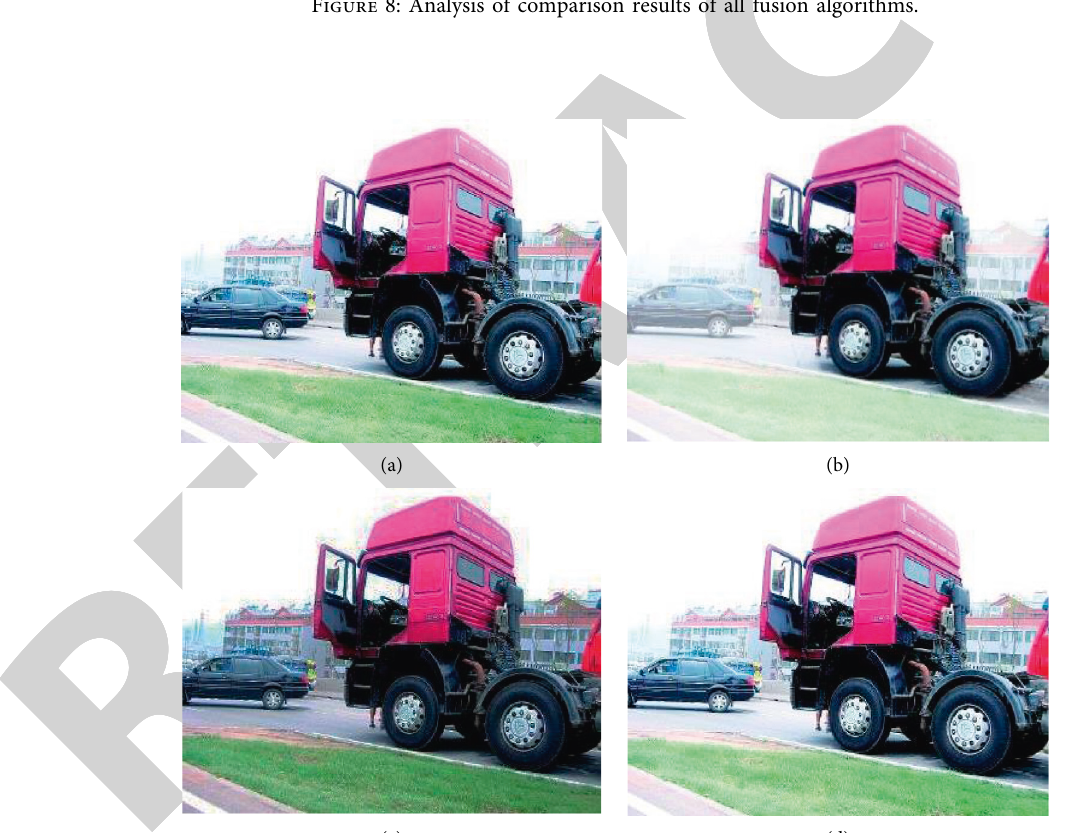
Figure 9: Analysis of experimental results of fusion algorithm: (a) original, (b) IHS fusion, (c) lifting wavelet fusion, and (d) algorithm proposed in this